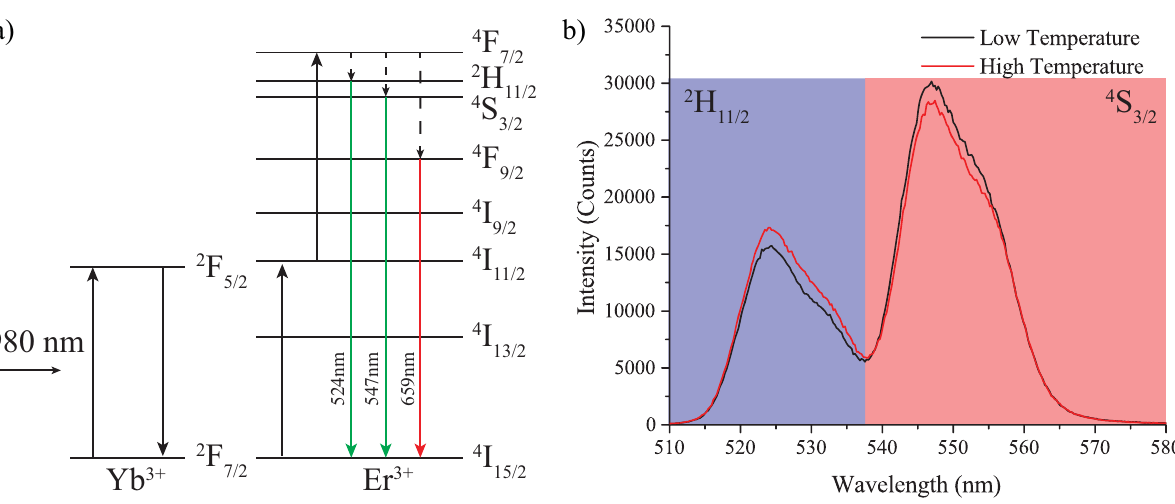
Figure 4. ( a ) Erbium ytterbium energy level diagram. ( b ) Example erbium ytterbium spectra for the two measured fluorescences. The two bands recorded to measure the fluorescence intensity are shaded in red and blue. Both low (23 °C, black) and high (39 °C, red) temperature emission spectra are shown, demonstrating the variation in the emission ratio of the two bands with changing